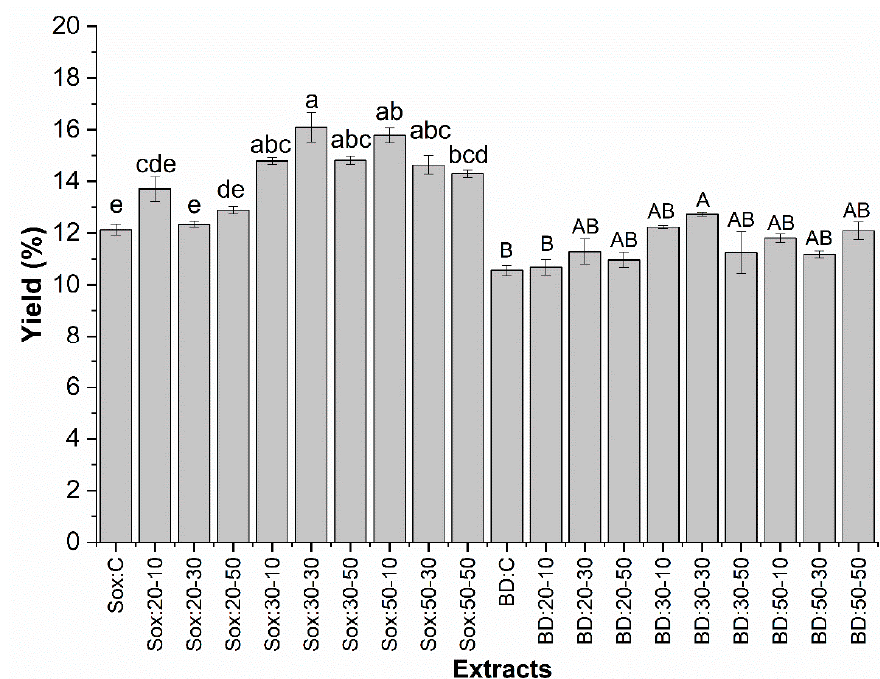
Figure 2. Determination of yield (%) of grape seed oil using different treatment conditions (time and temperature) with ultrasound and control sample (C) obtained by low pressure methods (Sox and BD). The bars in each column represent the standard error. Samples with the same lowercase letter (Sox extraction) and the same uppercase letter (BD extraction), showed no significant difference (p > 0.05) by the Tukey test with 95% confidence.